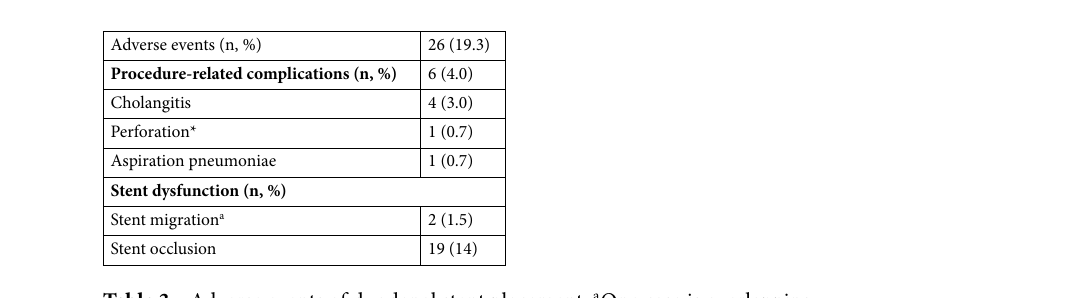
Table 3. Adverse events of duodenal stent placement. a One case is